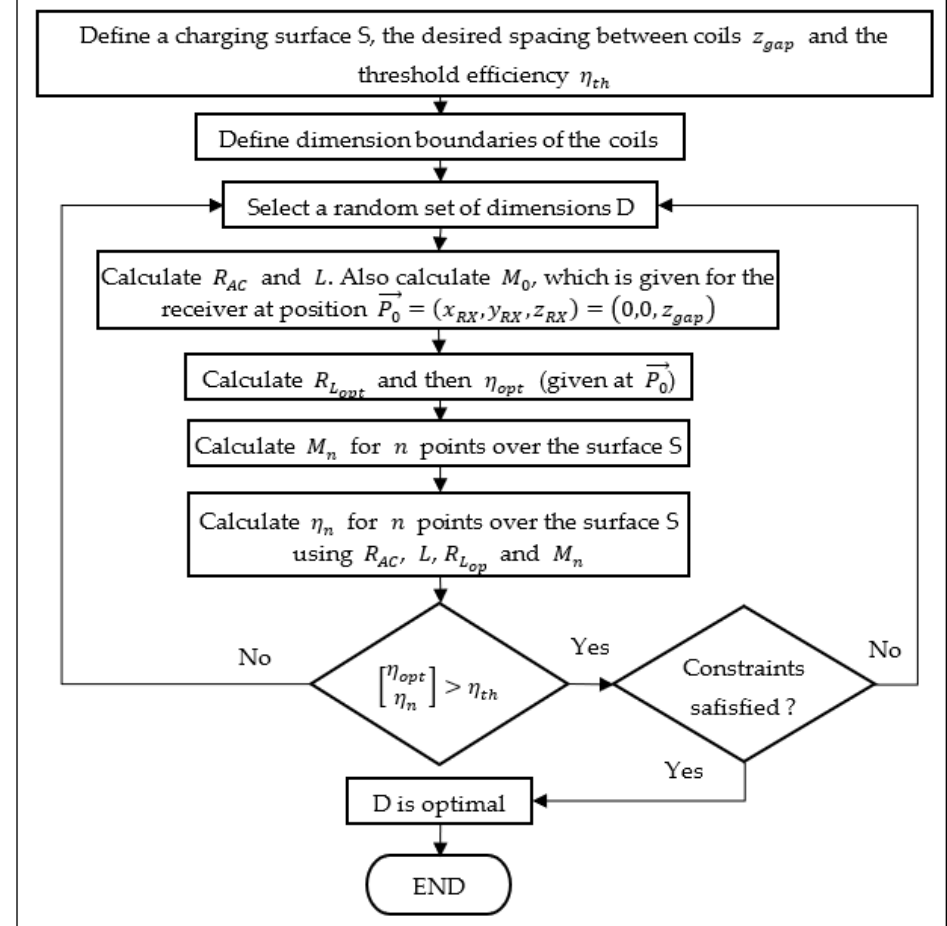
Figure 5. Flowchart of the proposed optimization procedure.